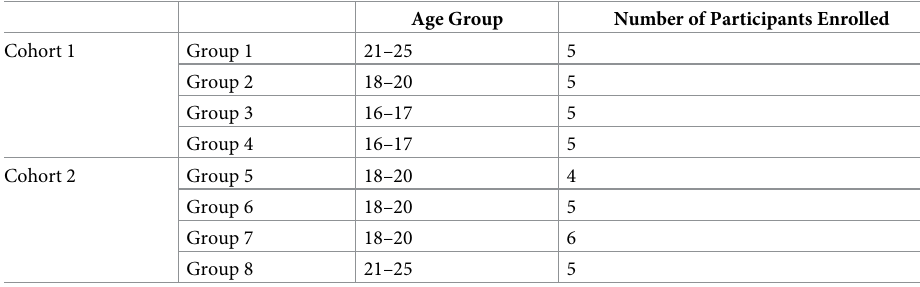
Table 2. Age demographic focus group section assignment by recruitment cohort.